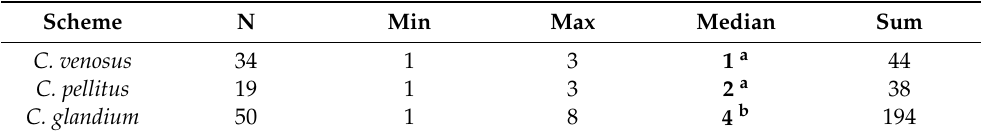
Table 2. Sample sizes, minimal, maximal and median values, as well as the total number of eggs laid into acorns by particular species. Significant differences are marked with different letters. Bold fonts means the main variable upon which statistical evaluation is